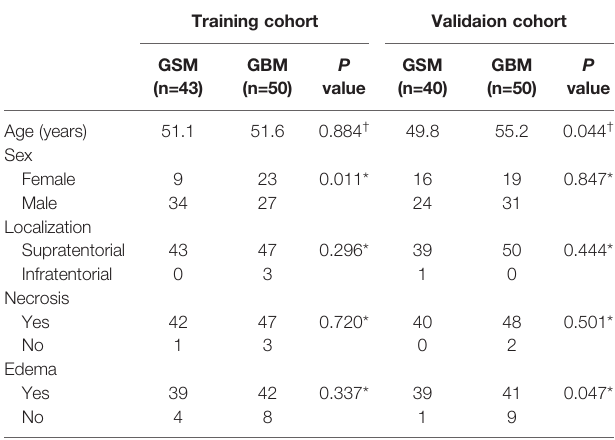
TABLE 1 | Clinical and MRI characteristics of patients with GSM and